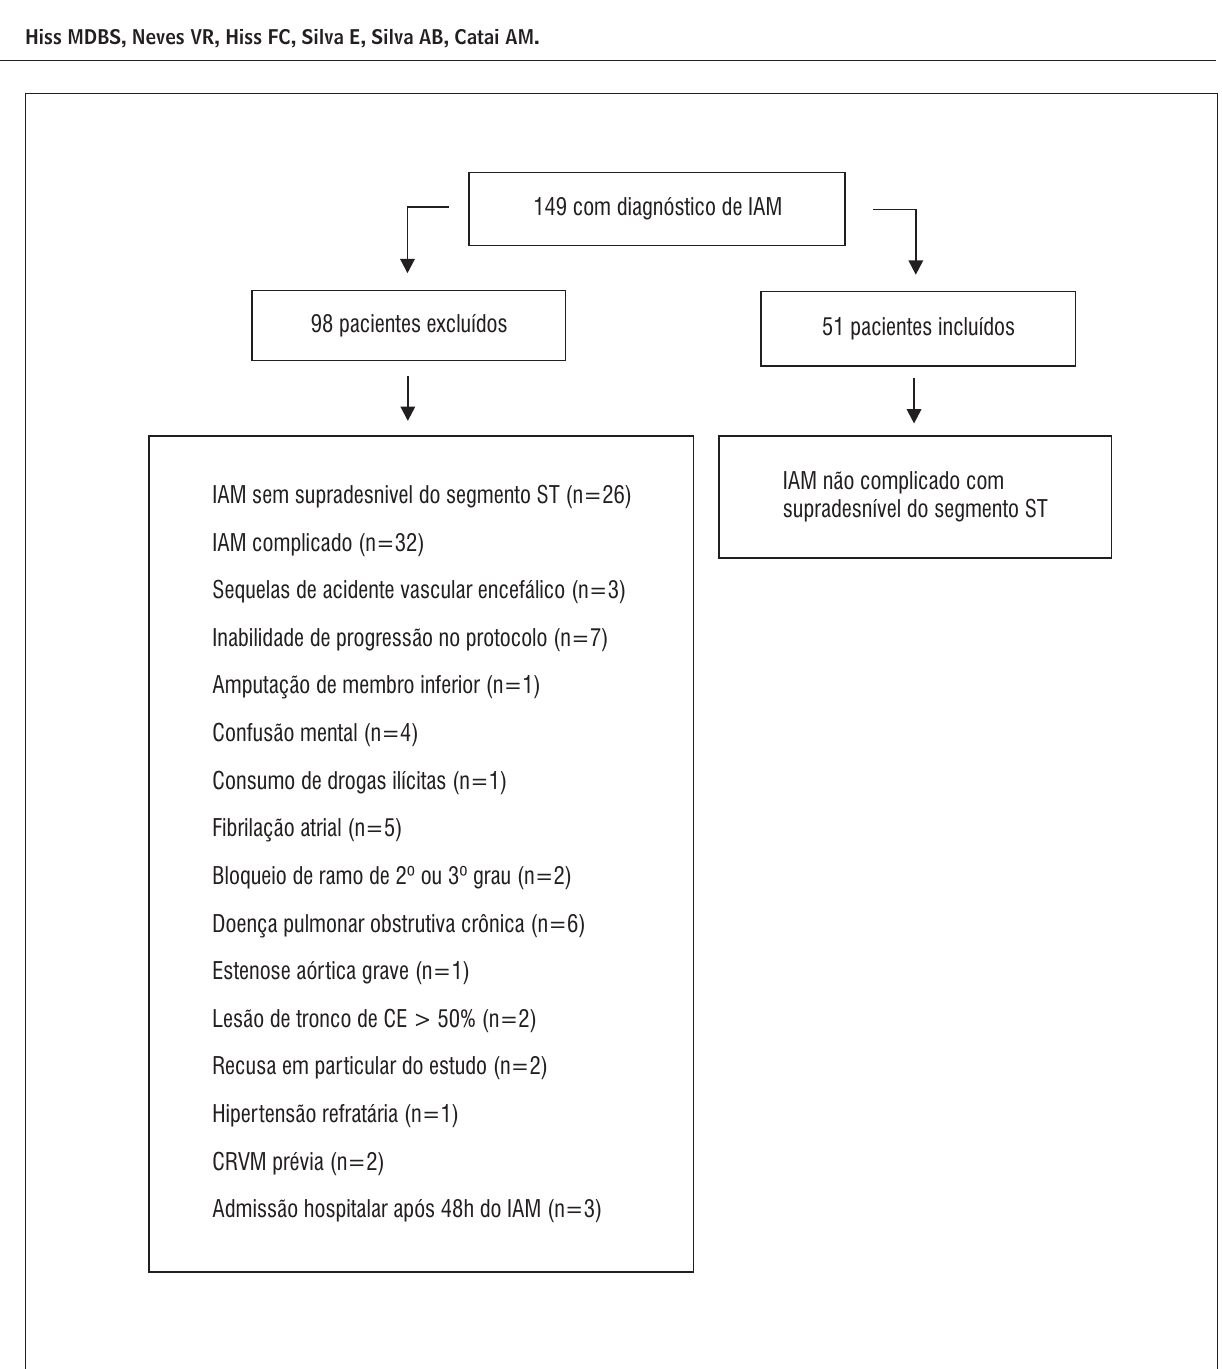
Figura 1 - Fluxograma representativo do processo de triagem dos pacientes do protocolo Legenda: IAM = infarto agudo do miocárdio; CE = Coronária esquerda; CRVM = cirurgia de revascularização do miocárdio. Fonte: Dados da